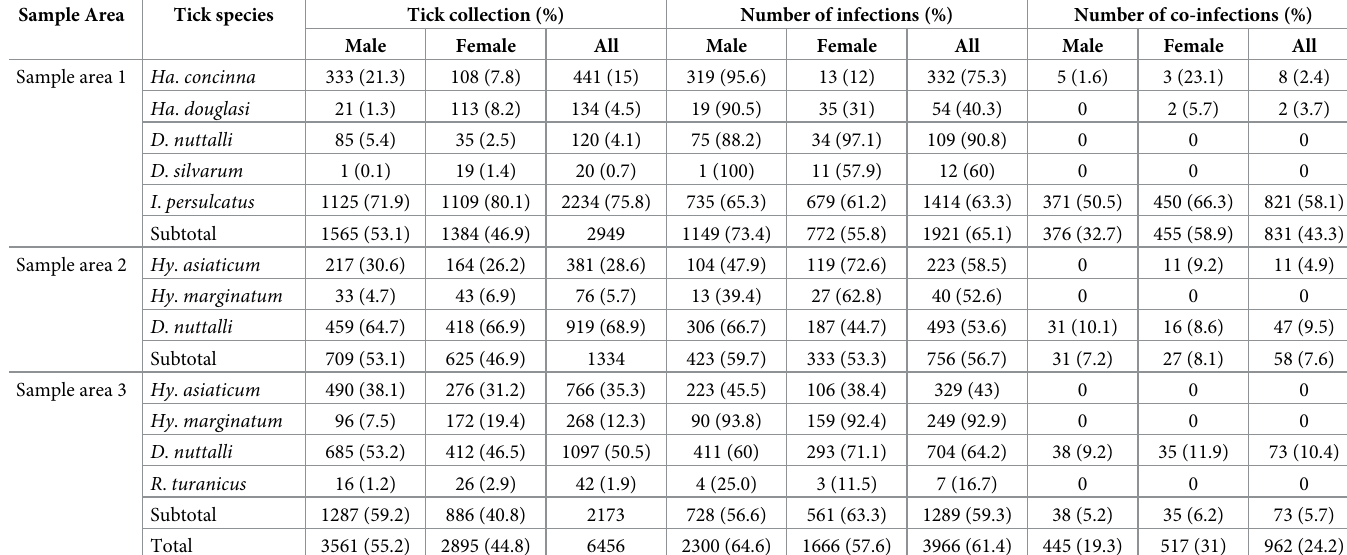
As shown in Table 2, tick-borne pathogens were detected in 61.4% (3966/6456) of all ticks col- lected from all sampling sites. The infection frequencies for male and female ticks were 64.6% (2300/3561) and 57.6% (1666/2895), respectively (Table 2). In sampling area 1, of the 2949 ticks collected, 1921 were infected, with an infection rate of 65.1% (1921/2949). The infection rates for different tick species varied greatly. D . nuttalli had the highest infection rate of 90.8% (109/120), followed by Ha . concinna , I . persulcatus , and D . silvarum with 75.3% (332/441), 63.3% (1414/2234), and 60.0% (12/20) infection rates, respectively. Ha . douglasi showed the lowest infection rate of 40.3% (54/134) compared with the other tick species ( χ 2 = 94.867, P < 0.001). In sampling area 2, of the 1334 ticks collected, 756 were PCR-positive, with an infection rate of 56.7% (756/1334). The infection rates of Hy . asiaticum , D . nuttalli , and Hy . marginatum were 58.5% (223/381), 53.6% (493/919), and 52.6% (40/76), respectively ( χ 2 = 2.770, P = 0.250). In sampling area 3, of the 2173 ticks collected, 1289 were PCR-positive, with an infection rate of 59.3% (1289/2173). The infection rate for different tick species varied greatly. Hy . marginatum had the highest infection rate of 92.9% (249/268), followed by D . nut- talli and Hy . asiaticum with infection rates of 64.2% (704/1097) and 43.0% (329/766), respec- tively. R . turanicus had the lowest infection rate of 16.7% (7/42) ( χ 2 = 252.747, P < 0.001) (Table 2 and Fig 1). Sequencing of the PCR products revealed that the SFGR gltA gene shared 100% identity with Rickettsia raoultii (accession no. DQ365803), Candidatus R. tarasevichiae (accession no. MN450397), and Rickettsia sp. strain YN02 (accession no. KY411135). We performed rOmpA PCR of the gltA PCR-positive samples and confirmed that the results were consistent. Ehrli- chial p28 / omp-1 multigenes were detected in E . chaffeensis (accession no. CP007480) (62.5%– 100%), E . ewingii (accession no. AF287964) (65.5%–100%), E . muris (accession no. AB178807) (72.5%–100%), and Ehrlichia sp. strain HF565 (accession no. AB178803) (67.5%–100%). Ana- plasma p44 / msp2 multigenes were detected in Anaplasma phagocytophilum (accession no. BAN28309) (67.5%–100%). The borrelial flaB and glpQ genes shared 100% identity with Borre- lia afzelii strain HLJ01 (accession no. CP003882), Borrelia garinii strain NMJW1